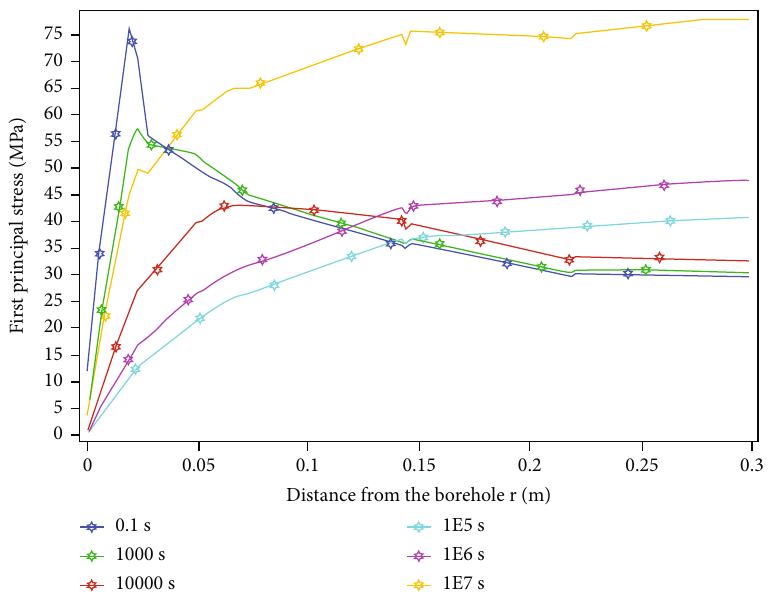
Figure 5: First principal stress in the homogeneous coal rock during CBM